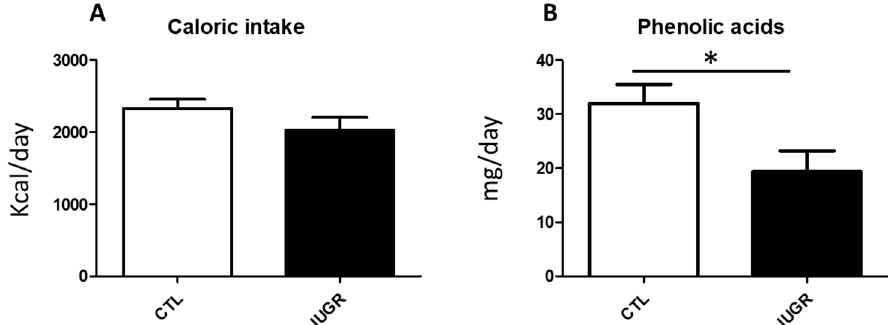
Figure 1. Caloric and phenolic alcohol (Tyrosol and Hydroxytyrosol) daily intake in control (CTL) vs. intrauterine growth restriction (IUGR) in pregnant women. ( A ). Conserved trend of caloric intake between CTL and IUGR pregnant women. ( B ). The daily intake of phenolic alcohols (tyrosol and HXT) is significative lower in IUGR when compared to CTL pregnant women. Results are expressed as means and standard error of the mean (SEM) (* p <